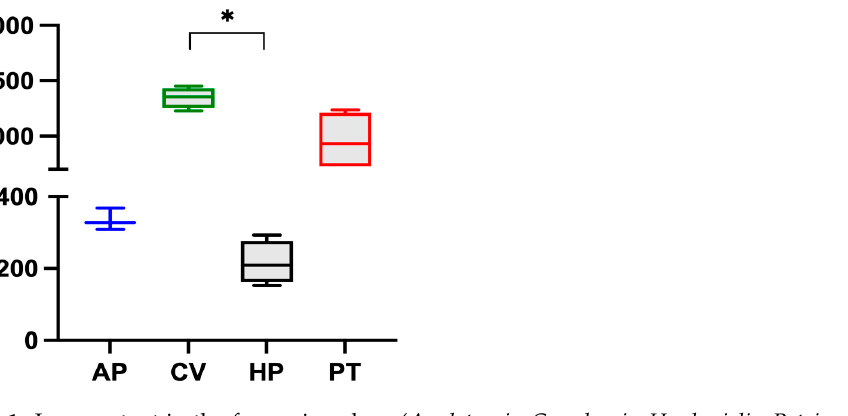
Figure 1. Iron content in the four microalgae ( A. platensis, C. vulgaris, H. pluvialis , P. tricornutum ) analysed. The data are expressed as micrograms per gram of dry algae biomass and are reported as medians and interquartile ranges. * Significantly different for the Dunn post-hoc test ( p < 0.05). Of the four species examined, C. vulgaris had the highest iron content (1347 ± 93 µ g g − 1 ). The value was in the range of those reported by other authors. Muszynska et al. (2017) [12] analysed different commercial samples of C. vulgaris and found iron contents ranging from 880 to 2112 µ g g − 1 while Kejzar et al. (2021) [23] found a value of 1000 ± 520 µ g g − 1